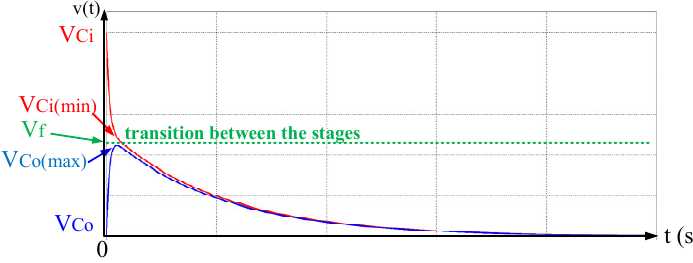
Figure 24. Circuit representing a capacitor discharging into a parallel RC circuit.